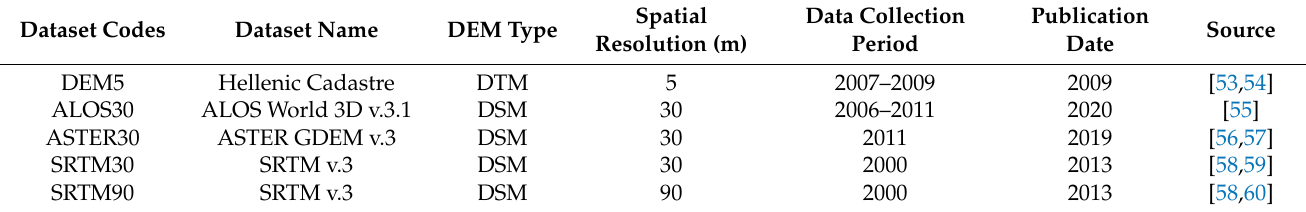
Table 1. The main features of DEM used in the current